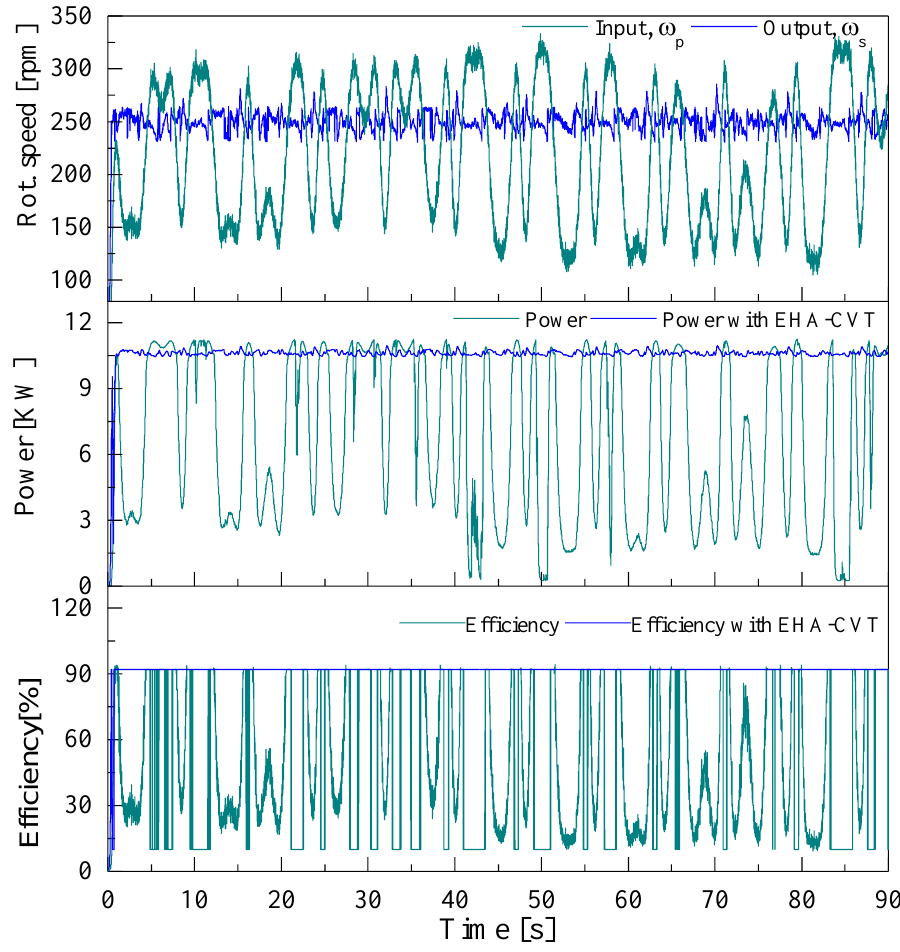
Figure 14. Generator efficiency.